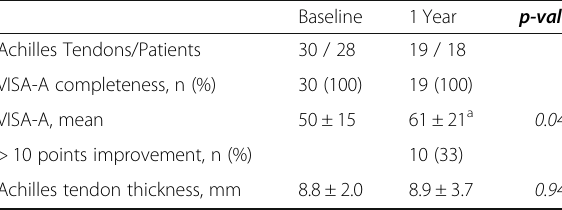
Table 2 VISA-A and Achilles tendon thickness